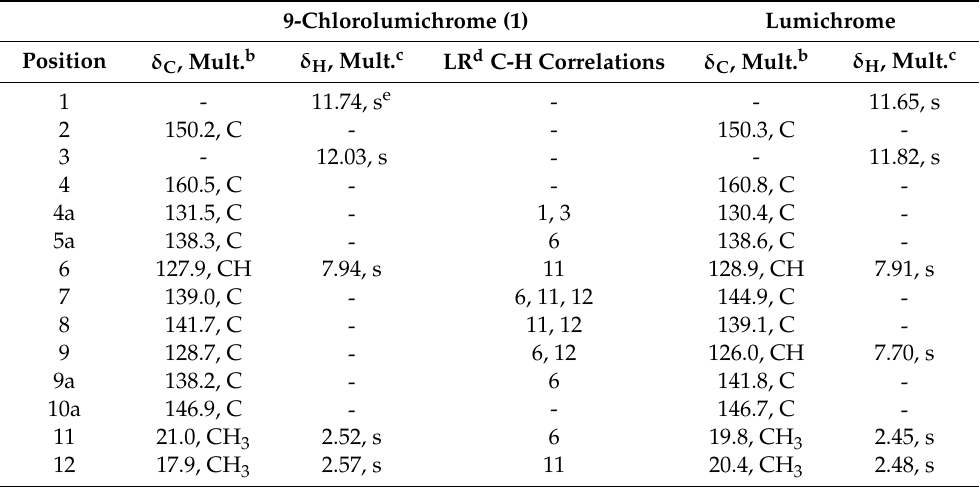
Table 1. NMR data of 9-chlorolumichrome ( 1 ) and lumichrome in DMSO- d 6a .